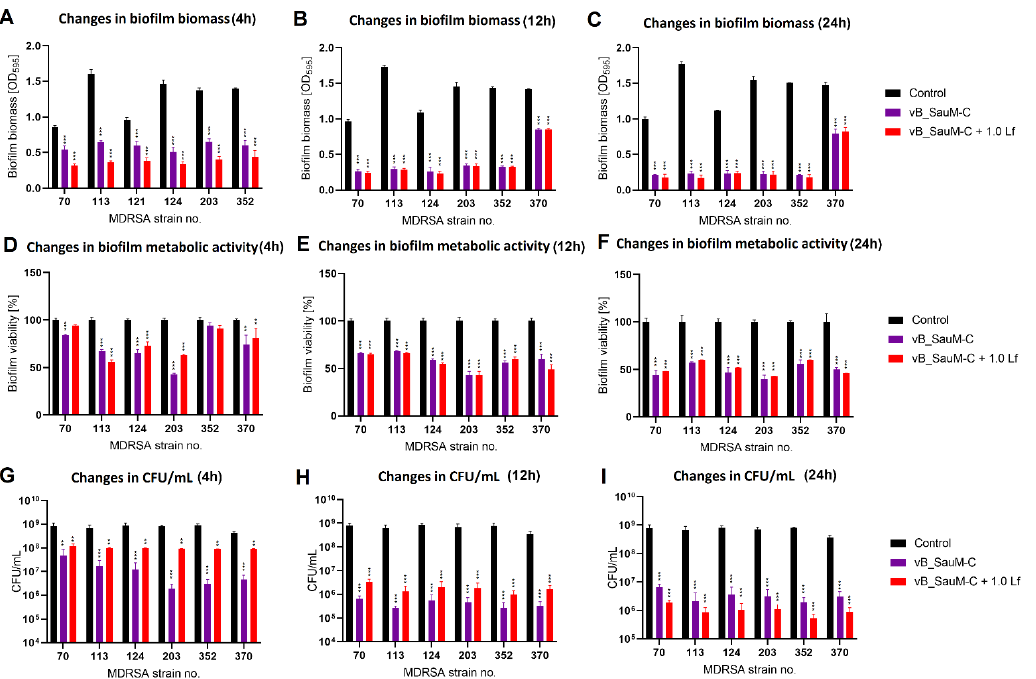
Figure 6. Influence of phage vB_SauM-C and vB_SauM-C+ 1.0 mg/mL lactoferrin (Lf) on MDRSA